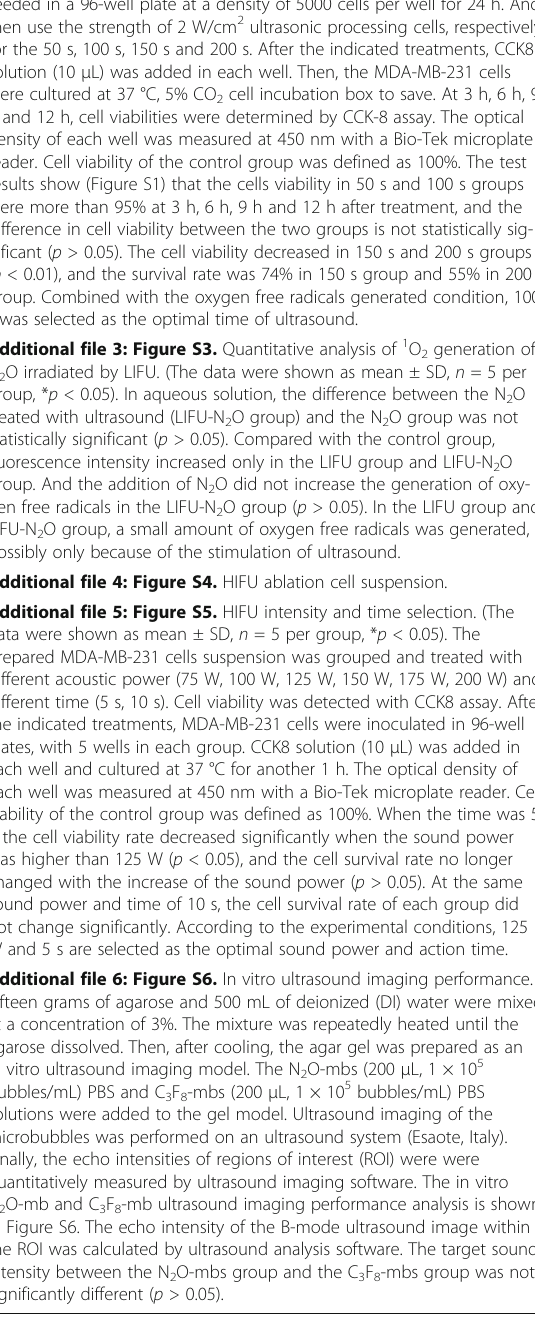
Additional file 1: Figure S1. Basic representation of C 3 F 8 -mbs. A. Photographs of C 3 F 8 -mbs dispersed in deionized water; B. Image of C 3 F 8